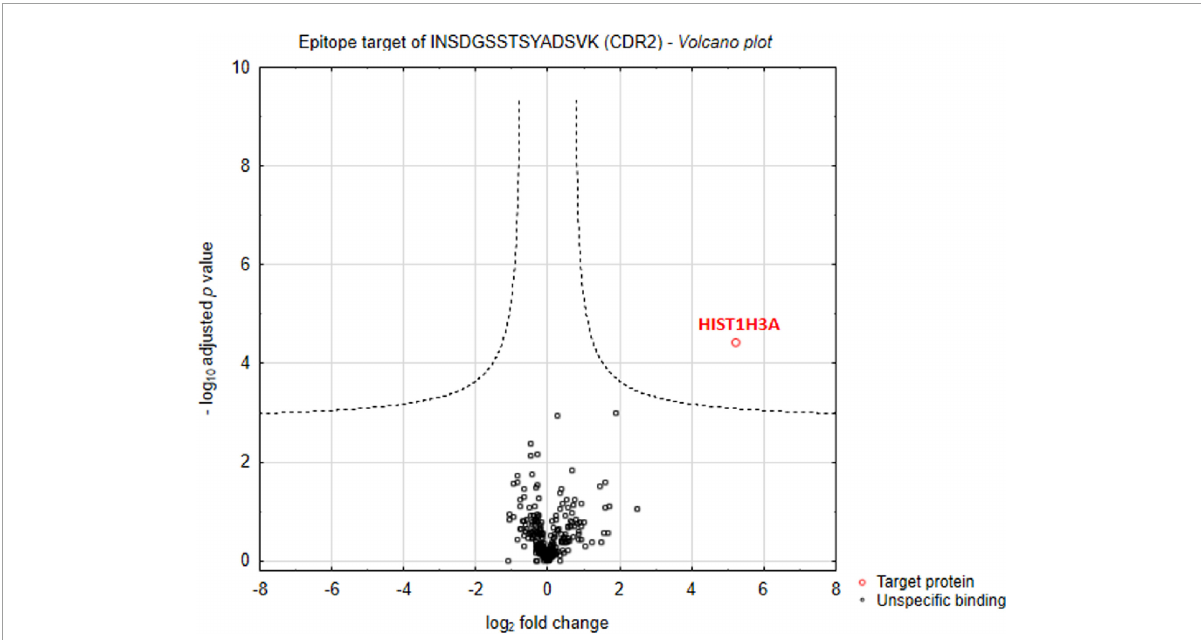
FIGURE1 Identification of complementary-determining region 2 (CDR2)-specific interaction partners in porcine retina. Volcano plot shows log2-fold change as function of -log10-adjusted p -values for samples from the CDR2-coupled bead group versus samples from the biotin-coupled control bead group ( n = 3 per group; p < 0.001 and log2-fold change > 3). The protein histone H3.1 (HIST1H3A) was identified as major protein interaction partner of the synthetic CDR2 peptide